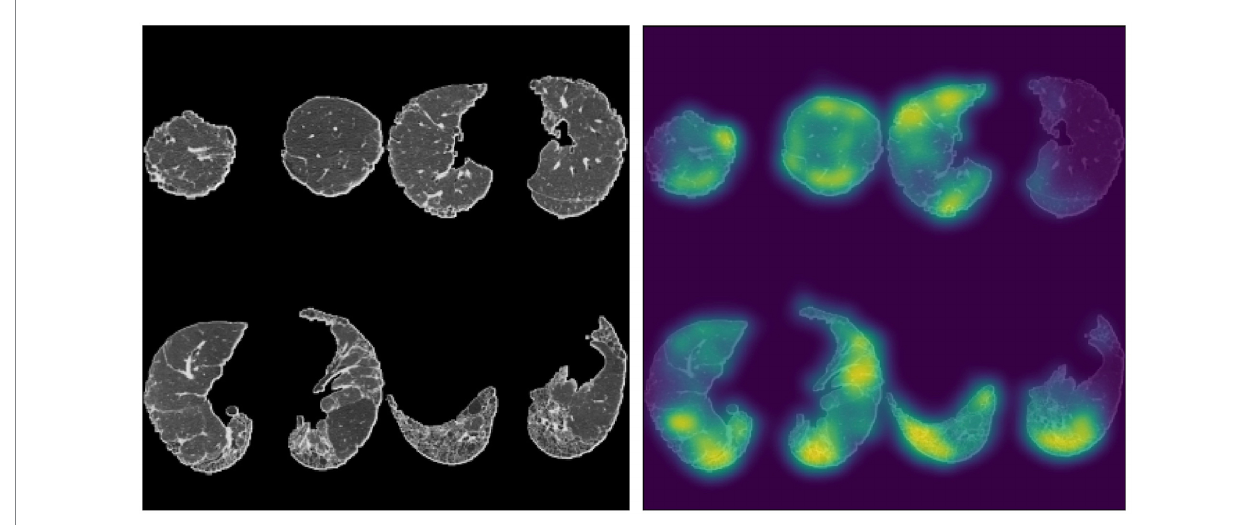
FIGURE 2 Four slice montage generated from a patient with an assigned HRCT diagnosis of probable UIP based on two expert thoracic radiologists, accompanied by a saliency map depicting parts of the lungs most influential in SOFIA-based decision-making. SOFIA probabilities for this montage were UIP: 0.224, probable UIP: 0.764, indeterminate for UIP 0.012, alternative diagnosis: 0.000. The SOFIA deep-learning algorithm generates up to 500 four axial slice montages from an HRCT scan by segmenting the lungs into quarters (excluding the apical 10%) and then randomly selecting slices from each quarter. The algorithm generates a set of numbers from 0 to 1, totalling 1.0, representing the probability of each of the UIP diagnosis categories (definite UIP, probable UIP, indeterminate, alternative diagnosis); which is the average probability for each diagnostic category across all the montages generated for each HRCT (85). Sourced and reproduced with permission from Simon L. F. Walsh, M.D., F.F.R.R.C.S.I., National Heart and Lung Institute, Imperical College London, London, United